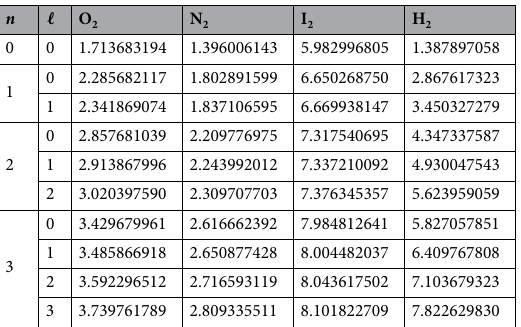
Table 6. Variance in momentum space of some diatomic molecules with (cid:31) = C = 1 for various n and ℓ .